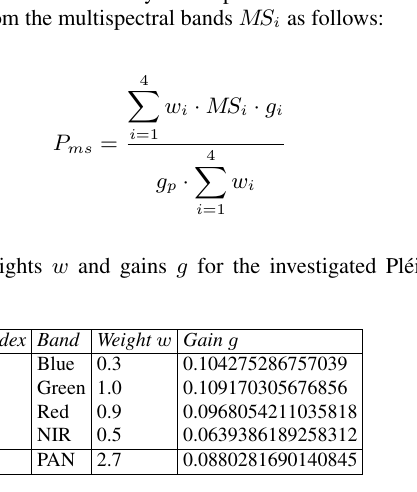
Figure 8: Focal plane assembly Pl´eiades (curvature of PAN sen- sor strongly exaggerated)